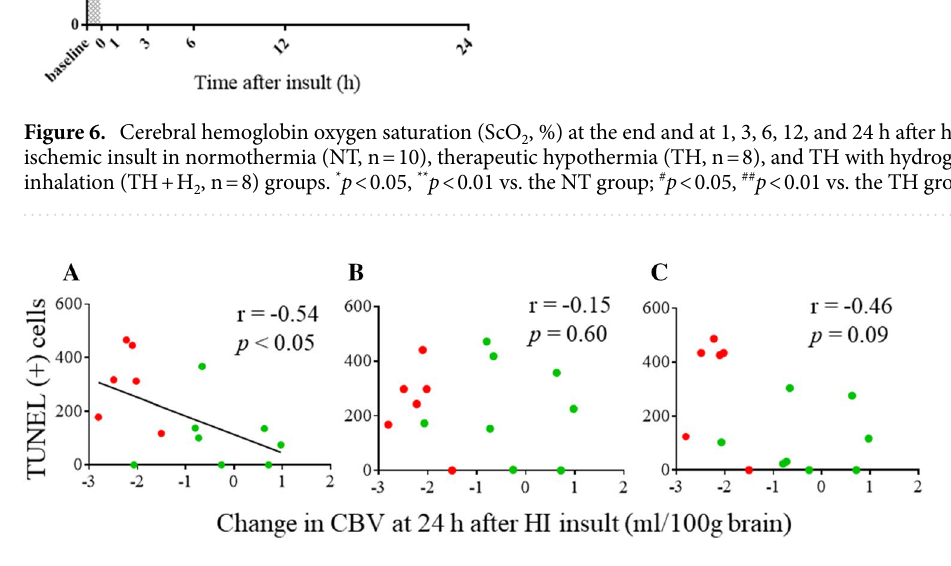
Figure 7. Relationship between the change in CBV 24 h after HI insult and the number of TUNEL (+) cells ( A , DCx; B , SMCx; C , MTCx). The change in CBV 24 h after HI insult is calculated by subtracting the value at the end of the HI insult from the value 24 h after the HI insult. The change in CBV 24 h after HI insult showed a significant negative correlation with the number of TUNEL (+) cells in the DCx